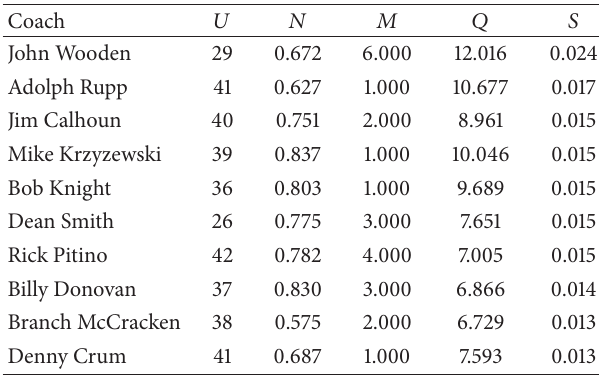
Table 10: Comparison of priority (basketball).